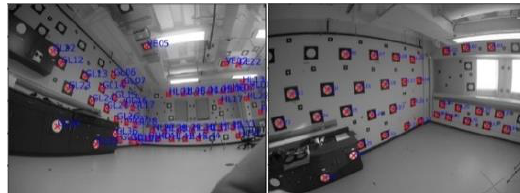
Figure 4. Example of GoPro Hero5 imagery with measured